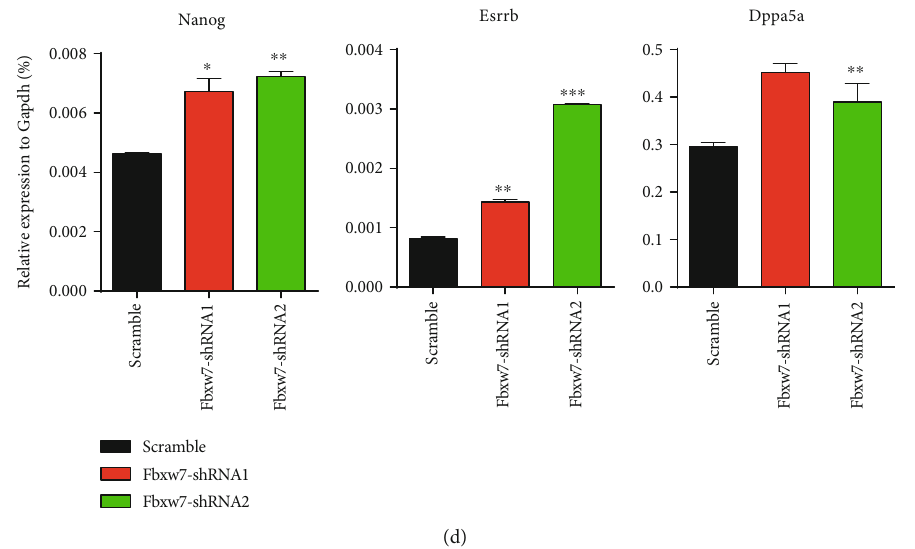
Figure 5: RT-qPCR analysis of the expression of three pluripotency factors in wild-type OG2 mESCs transfected with plko-shRNA of (a) Tcf7l1 , (b) p53 , (c) Jarid2 , and (d) Fbxw7 and treated by withdrawing 2i/LIF. The error bar represents standard error, ∗ P < 0 : 05 , ∗∗ P < 0 : 01 , ∗∗∗ P < 0 : 001 vs.